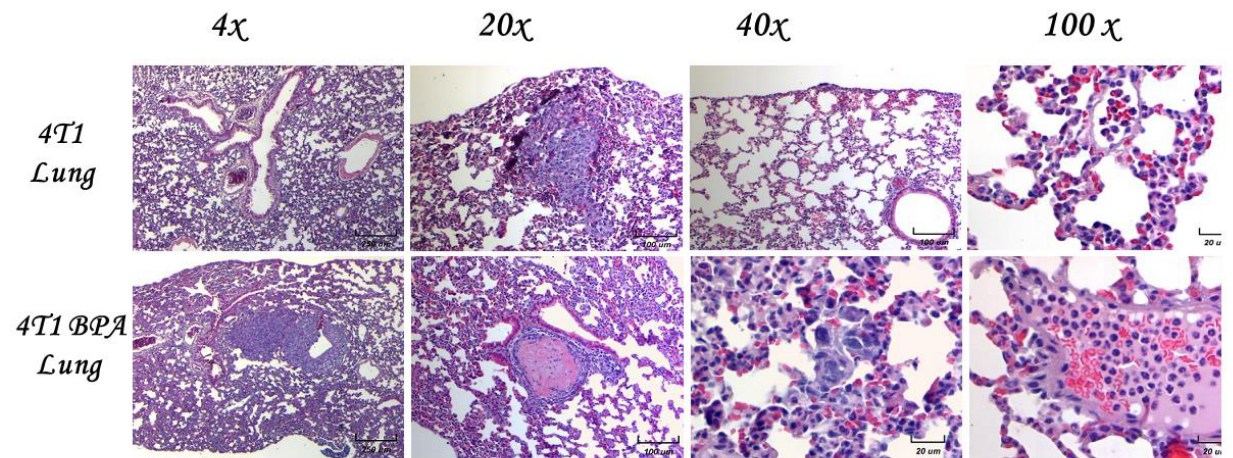
Figure 5. Histological examination of the lungs of female mice exposed to BPA without tumors. Representative images of the lungs in female mice exposed to BPA without tumor induction at different magnifications (4×, 20×, 40×, and 100×).